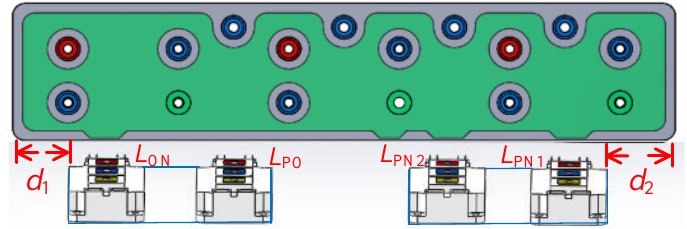
70 mm (0 < d 1 < 70 mm , 0 < d 2 < 70 mm ), where L ON , L PO , L PN1 and L PN2 respectively represent the busbar stray inductance of each switching loop.